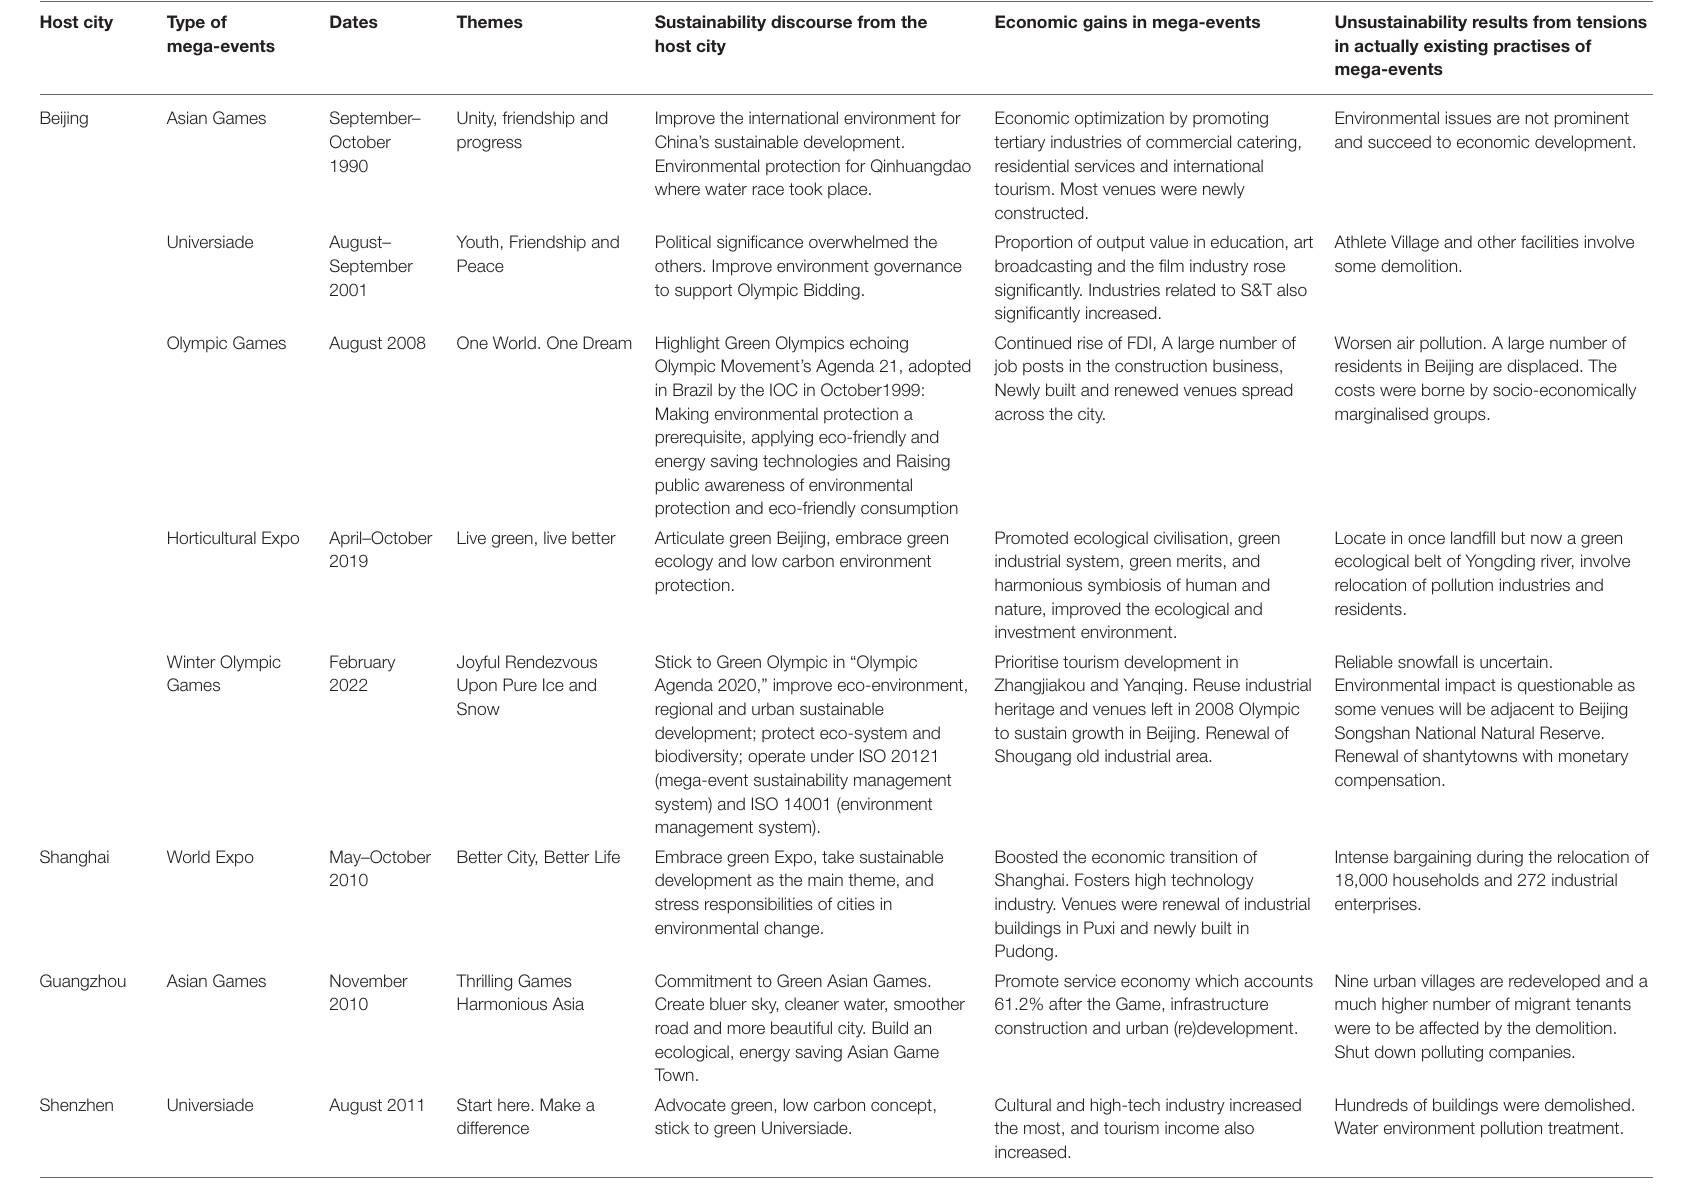
TABLE 1 | Sustainability discourse, economic gains, and sustainability challenges of mega-events in Chinese metropolises